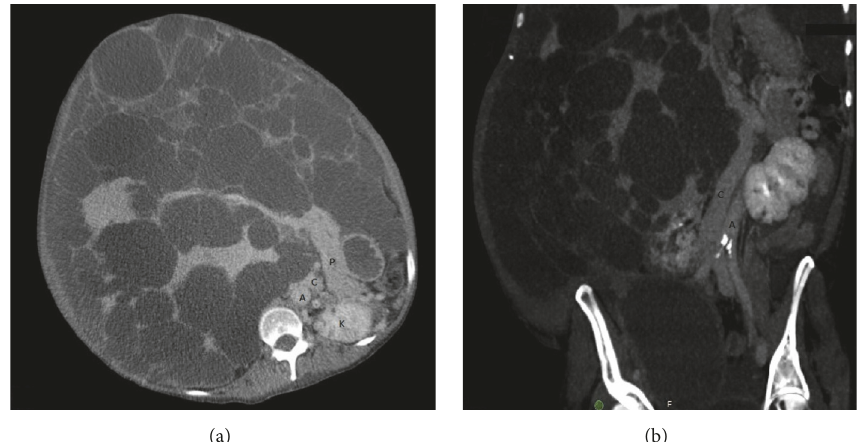
Figure 1: (a) Axial section CT showing abdominal anatomy with kidney (K) and pancreas (P) in relation to liver. (b) Coronal plane CT venogram showing vena cava (C) pushed on the left side of the aorta (A).